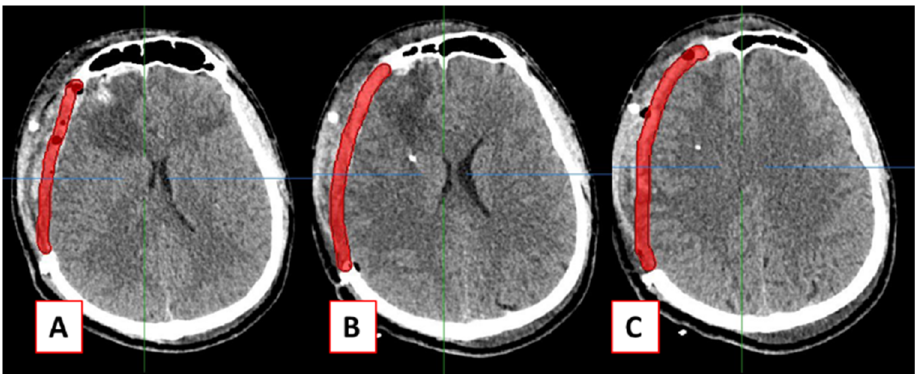
Figure 4. Slices ( A ) 151, ( B ) 161, and ( C ) 171 of every tenth slice. Once the line drawing of every tenth axial slice was performed, the 2D interpolation was executed applying the shape-based interpolation method, and the 3D cranial implant was successfully created, but not all surfaces of implants were reconstructed due to under- interpolation as shown in Figure 5.